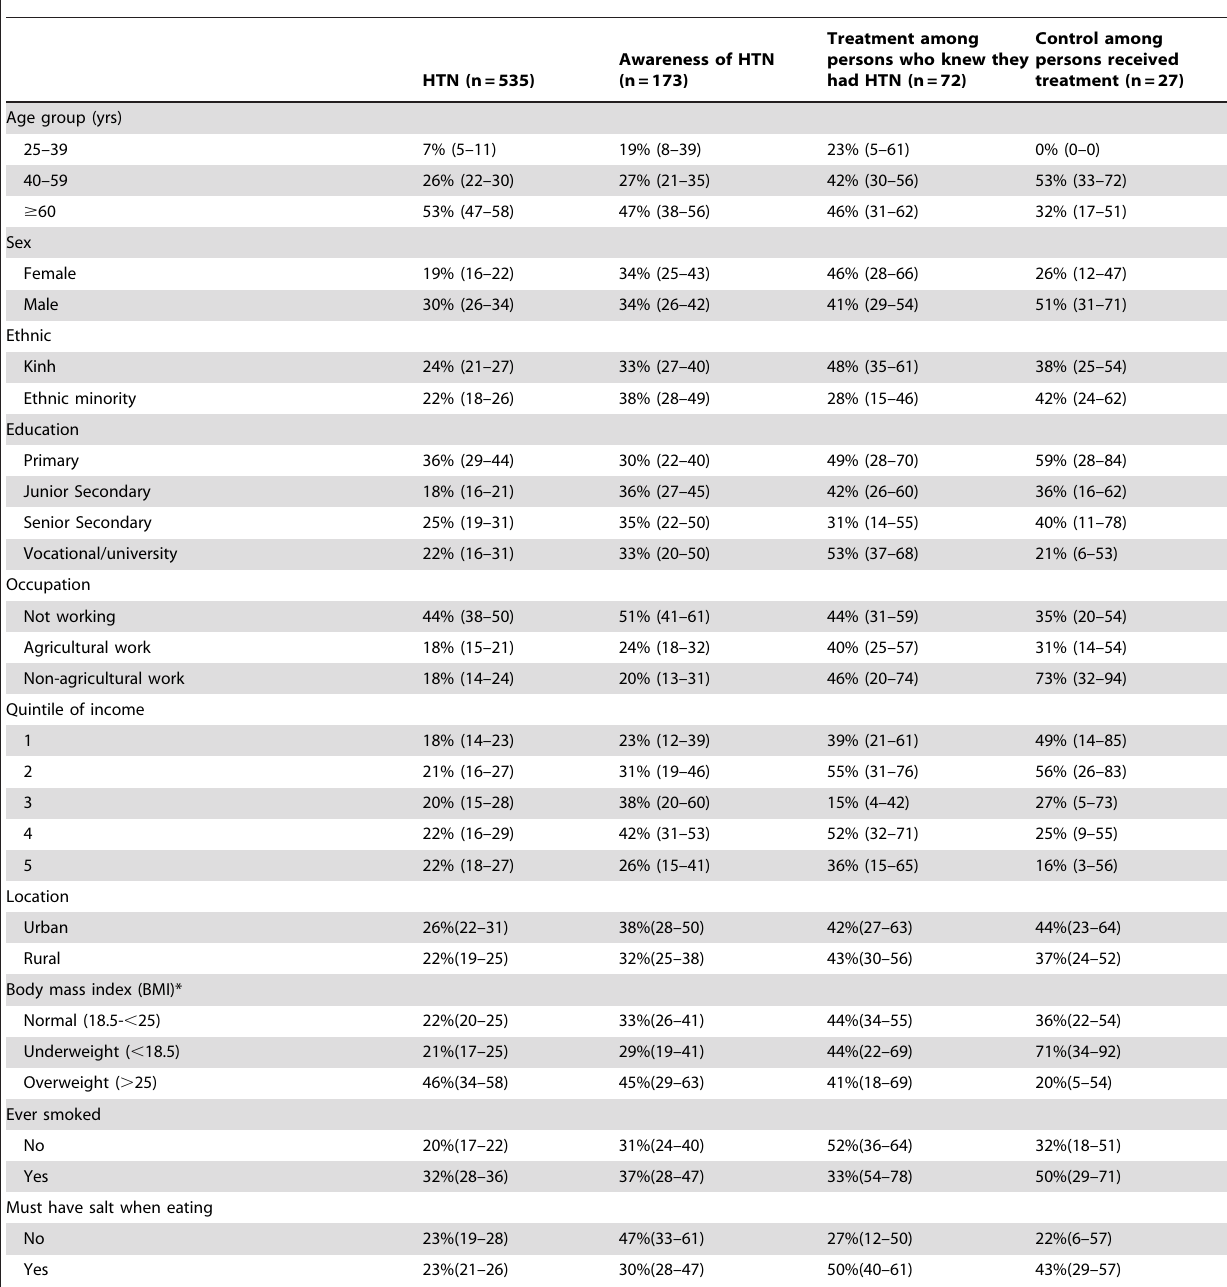
Table 2. Prevalence, Awareness, Treatment, and Control of Hypertension (HTN) (95%CI) according to Selected Population